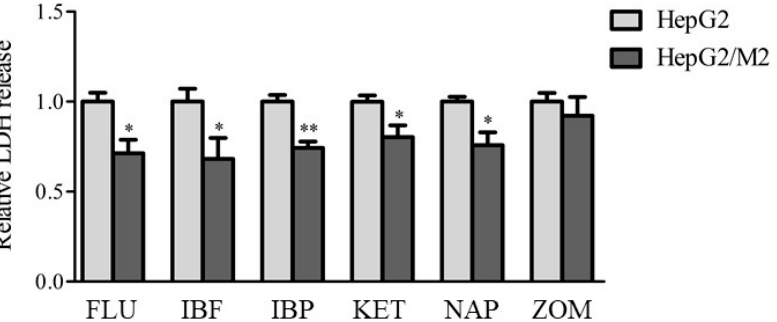
Figure 3. Relative LDH release to HepG2 alone in indirect co-culture HepG2/M2 (1:0.4) 24 h after treatments of FLU (500 µ M), IBF (1 mM), IBP (1 mM), KET (1 mM), NAP (1 mM), or ZOM (1 mM). The results are expressed as the mean ± SE of each group (n = 4–5). Significant differences (* p < 0.05 and ** p < 0.01 vs. HepG2) were observed.